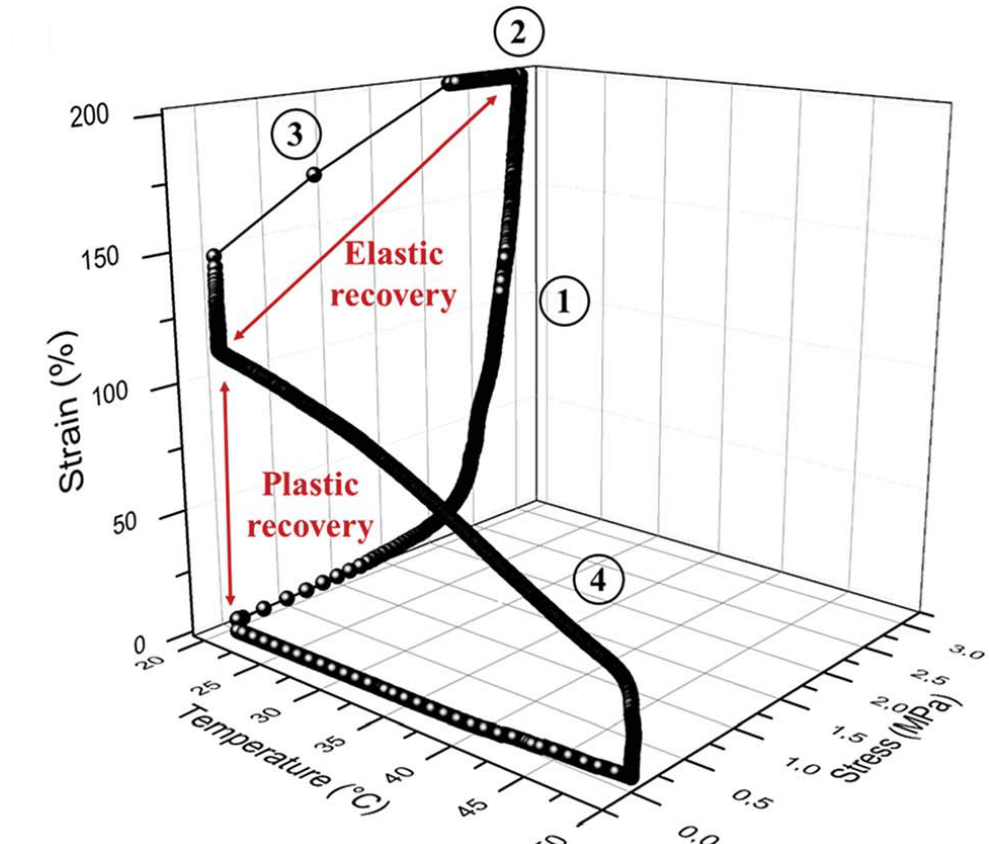
Figure 12. Cyclic stress-controlled thermomechanical test (DMTA) of the nanocomposite containing 20 wt% of nanosilica: (1) deformation, (2) fixation, (3) unloading and plastic recovery, and (4) heating and plastic recovery. Reprinted with permission from Odent et al.